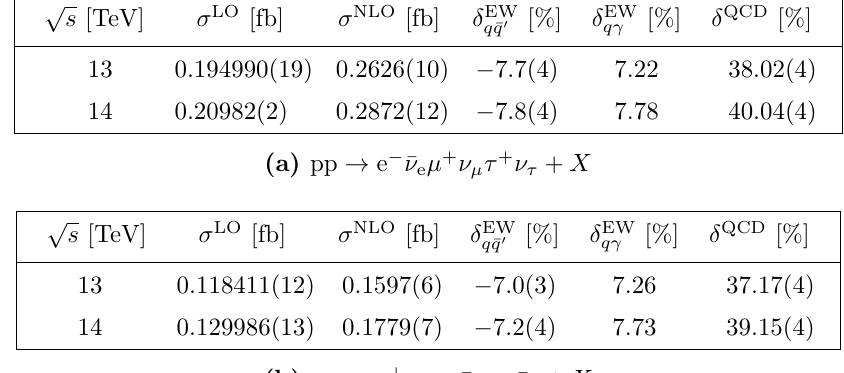
Table 3. LO and NLO cross sections, (cid:27) LO and (cid:27) NLO , as well as relative NLO corrections (cid:14) EW (cid:14) EW , and (cid:14) QCD at di(cid:11)erent CM energies q(cid:13) errors are indicated in parentheses.